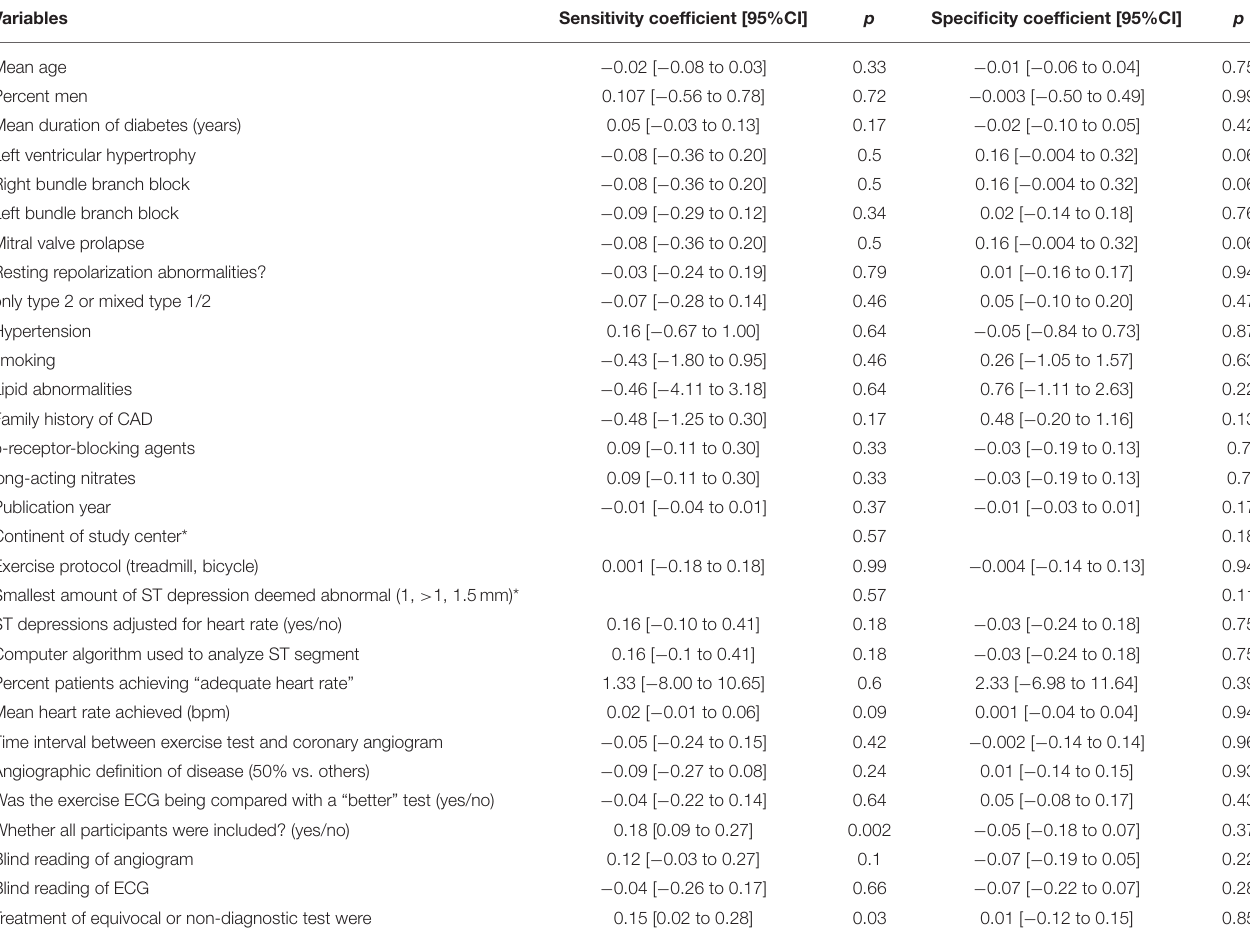
TABLE 3 | Variables associated with sensitivity and specificity by univariate regression analysis.